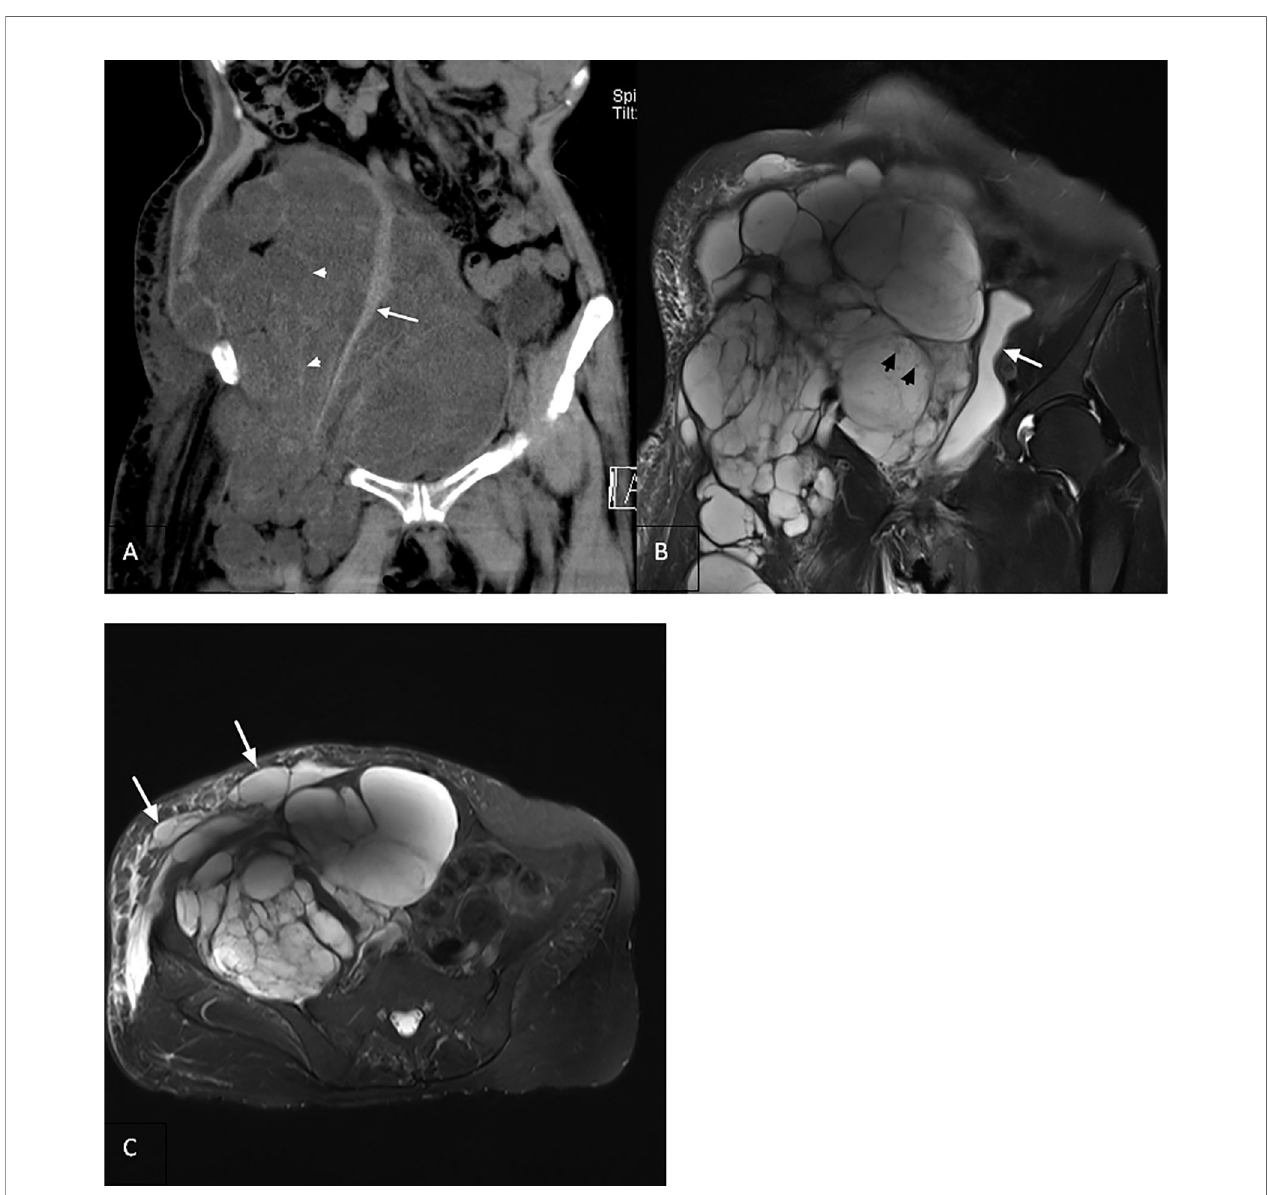
FIGURE 4 | (A) Coronal computed tomography reconstruction (2018) showing a multilocular cystic solid heterogeneous mass in the retroperitoneum with poorly delineated boundaries (arrowhead). Right psoas major muscle showing compressed atrophy and decrease in volume (arrow). (B) Coronal T2-weighted imaging revealing that the lesion invaded the retroperitoneum, inguinal region, and upper right thigh with uneven signal intensity. There are many divergent spots of slightly lower signal intensity (arrowhead) in the lesion, with uneven thickness of the septum. The bladder is compressed and moved to the left (arrow). (C) Axial view showing the right abdominal cyst with lymphedema